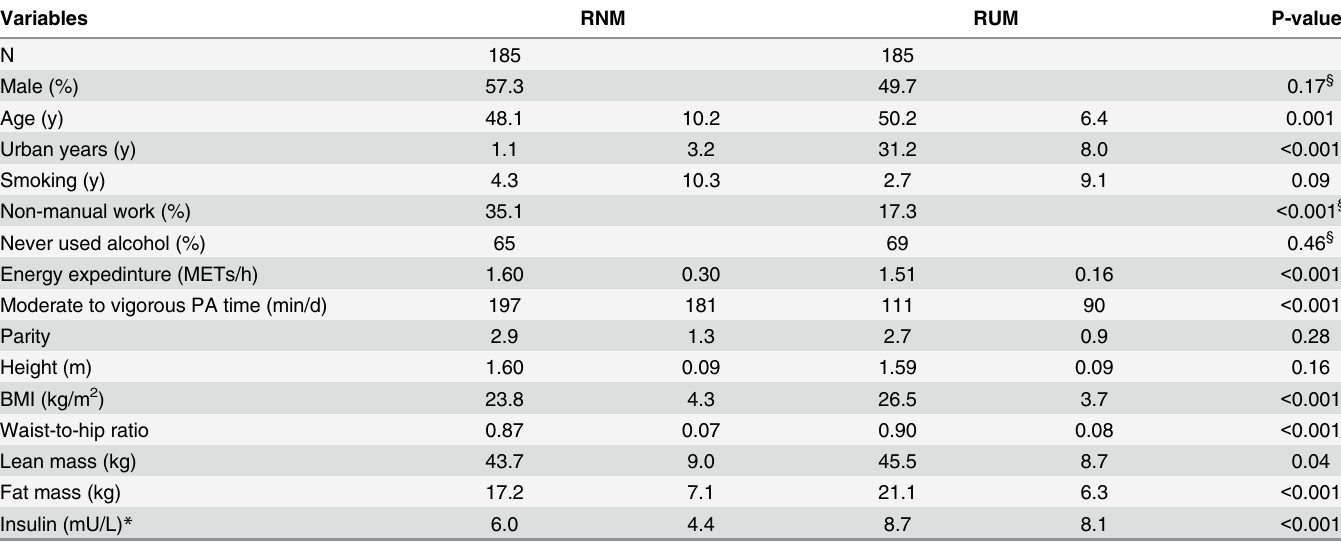
Table 1. Characteristics of matched groups of RNM and RUM (sibs) with mean and SD.